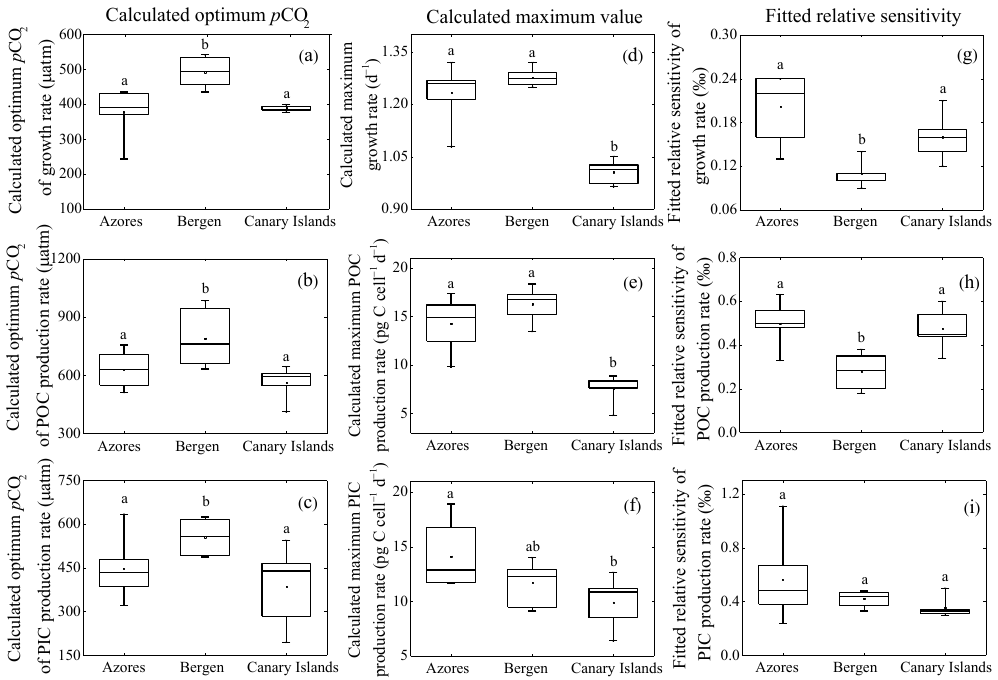
Figure 2. Calculated optimum p CO 2 , calculated maximum value and fitted relative sensitivity constant of growth, POC, and PIC production rates of each population. (a) optimum p CO 2 of growth rate; (b) optimum p CO 2 of POC production rates; (c) optimum p CO 2 of PIC production rates; (d) maximum growth rate, (e) maximum POC production rate, (f) maximum PIC production rate; (g) relative sensitivity constant of growth rate; (h) relative sensitivity constant of POC production rate; (i) relative sensitivity constant of PIC production rate. The line in the middle of each box indicates the mean of 6 or 5 optimum p CO 2 , 6 or 5 maximum values, and 6 or 5 relative sensitivity constants for growth, POC, and PIC production rates in each population. Bars indicate the 99% confidence interval. The maximum or minimum data are shown as the small line on the top or bottom of the bar, respectively. Letters in each panel represent statistically significant differences (Tukey HSD, p < 0 .